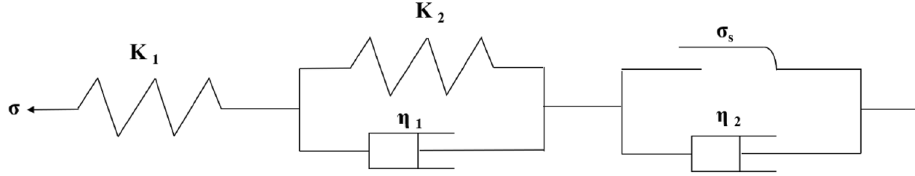
Figure 17. Nishihara Model Mechanical Model.